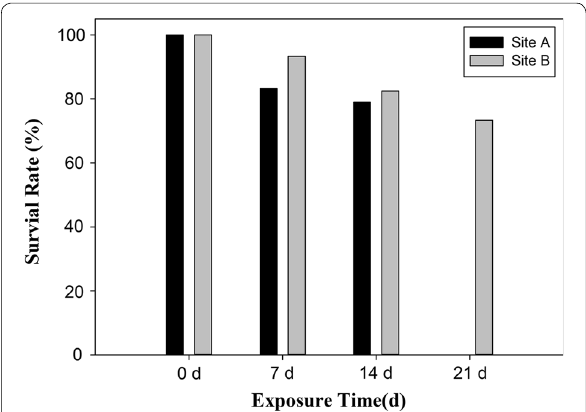
Fig. 2 Survival rate (%) of Bellamya aeruginosa caged at sites A and B during the caging exposure in Taihu Lake